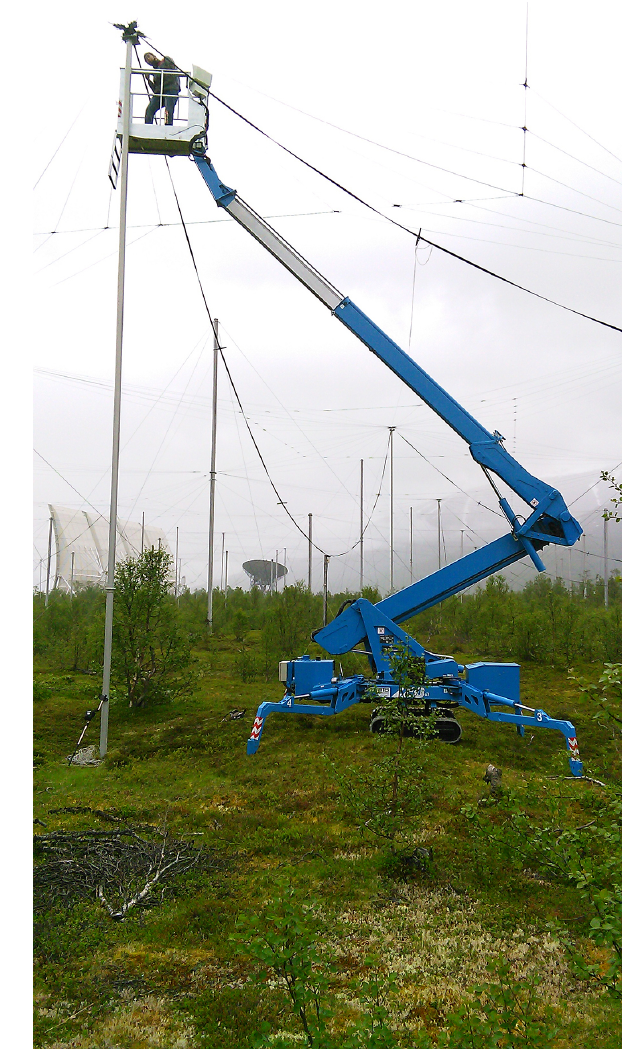
Figure 7. Repair work to one of the 12m high antennas out of 144 such antennas in Array 1 to bypass existing and potential weak points in the twin-feed cable connection to the antenna centre. The original 23m wooden masts are visible in the background. Note the different support mast and the different feed lines compared with the original design as used in Array 2 and Array 3, shown in Fig.